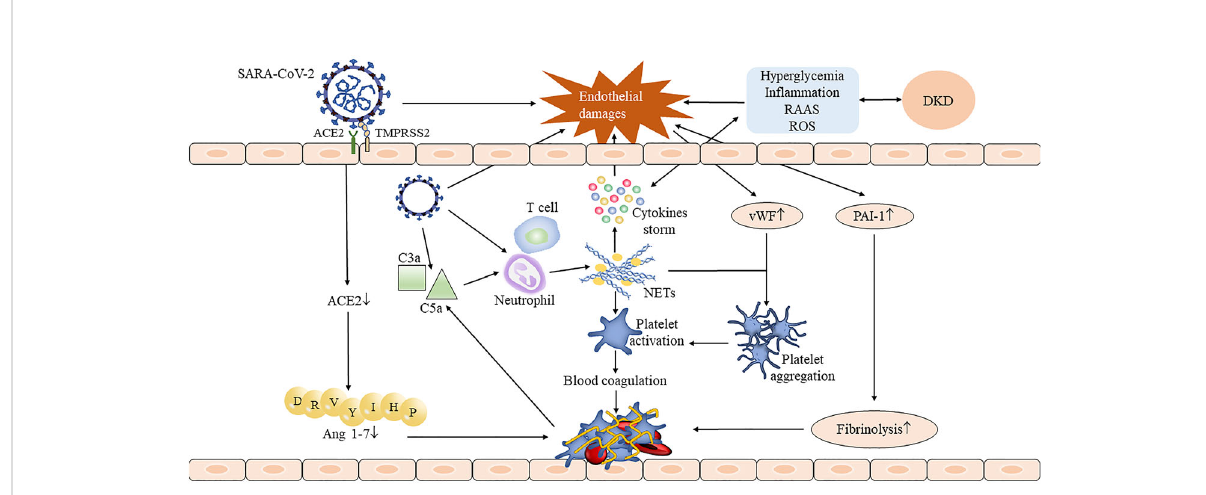
FIGURE 1 The process of thrombus formation in DKD complicated with COVID-19 patients. The invasion of SARS-CoV-2 damaged the integrity of the endothelium, and the injured endothelial cells stimulated the release of the von Willebrand factor (vWF) and plasminogen activator inhibitor-1 (PAI-1) and accelerated the formation of thrombosis. SARS-CoV-2 activates neutrophils by activating the complement system, thus causing the release of neutrophil extracellular traps (NETs) (48). NETs not only stimulate the occurrence of the coagulation cascade and leads to subsequent thrombosis but also stimulates cytokine storm to further aggravate endothelial damage. Downregulated angiotensin-converting enzyme 2 (ACE2) reduced angiotensin 1-7 production which also contributed to the thrombosis. The presence of DKD may aggravate endothelial damage through in fl ammatory stimulation, hyperglycemia, and oxidative stress, resulting in a more serious